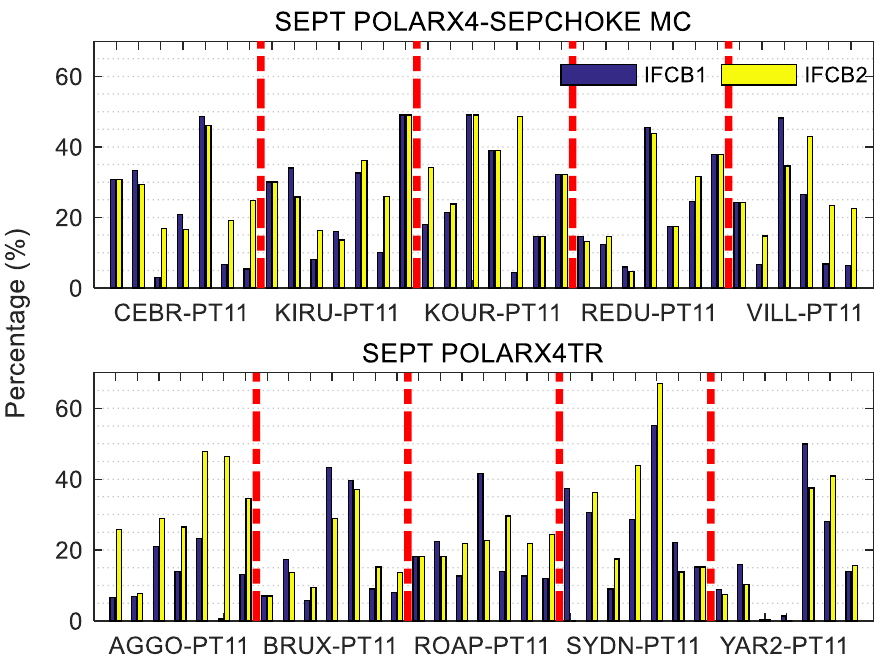
Figure 6. The improvement percentage of the GLONASS PPP with two handle schemes on some stations selected from the stations equipped with identical receivers ( top ) and mixed receivers ( bottom ).